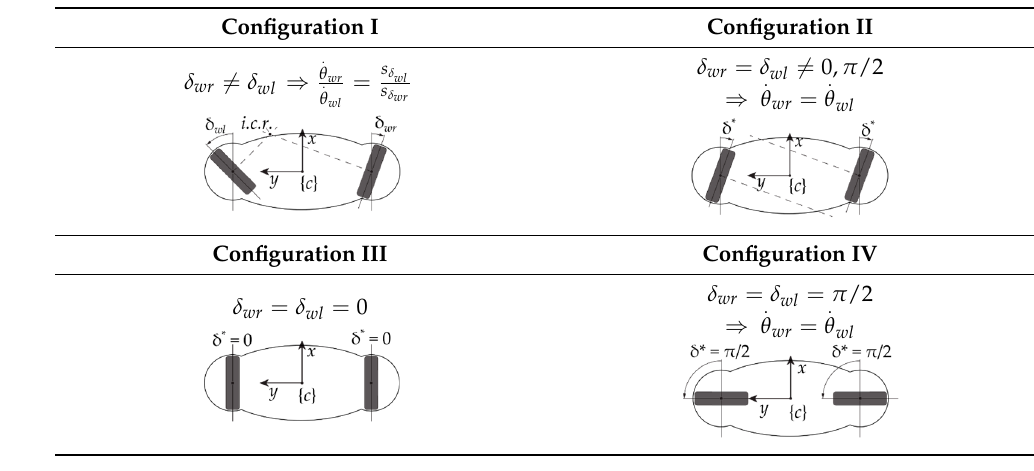
Table 1. Possible steering configurations of the over-actuated mobile robot.